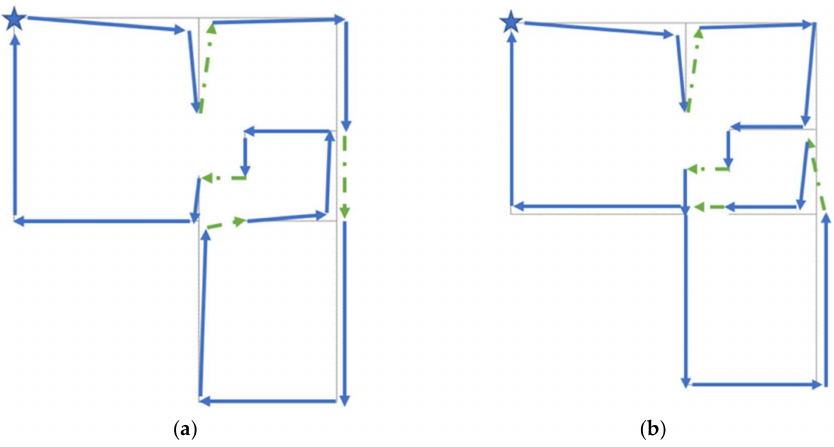
Figure 10. Fourteen-wall flat. The two solutions are with T = 6. ( a ) First solution with rectangular movements. ( b ) First solution with diagonal movements permitted. Table 8. Vertex coordinates and wall connectivities for Example 3 (14-wall flat).